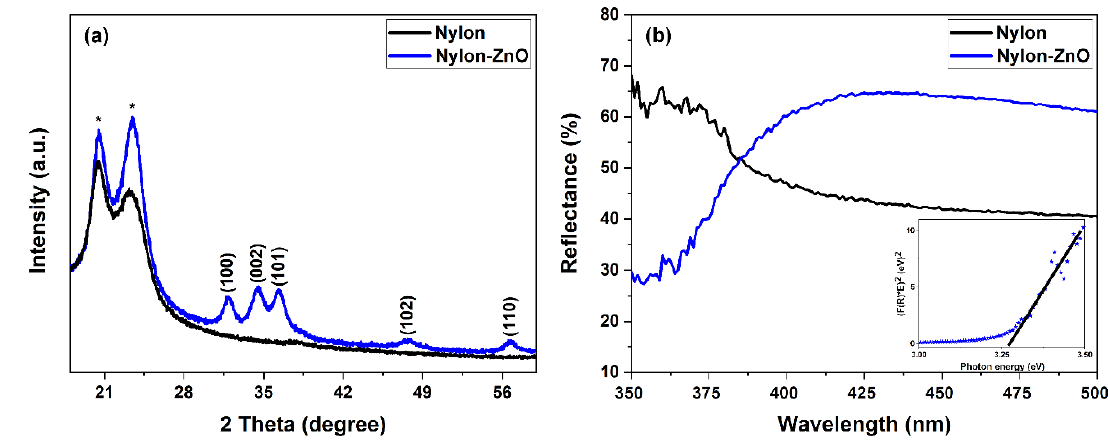
Figure 2. ( a ) XRD patterns and ( b ) reflectance spectra of the fabricated networks.